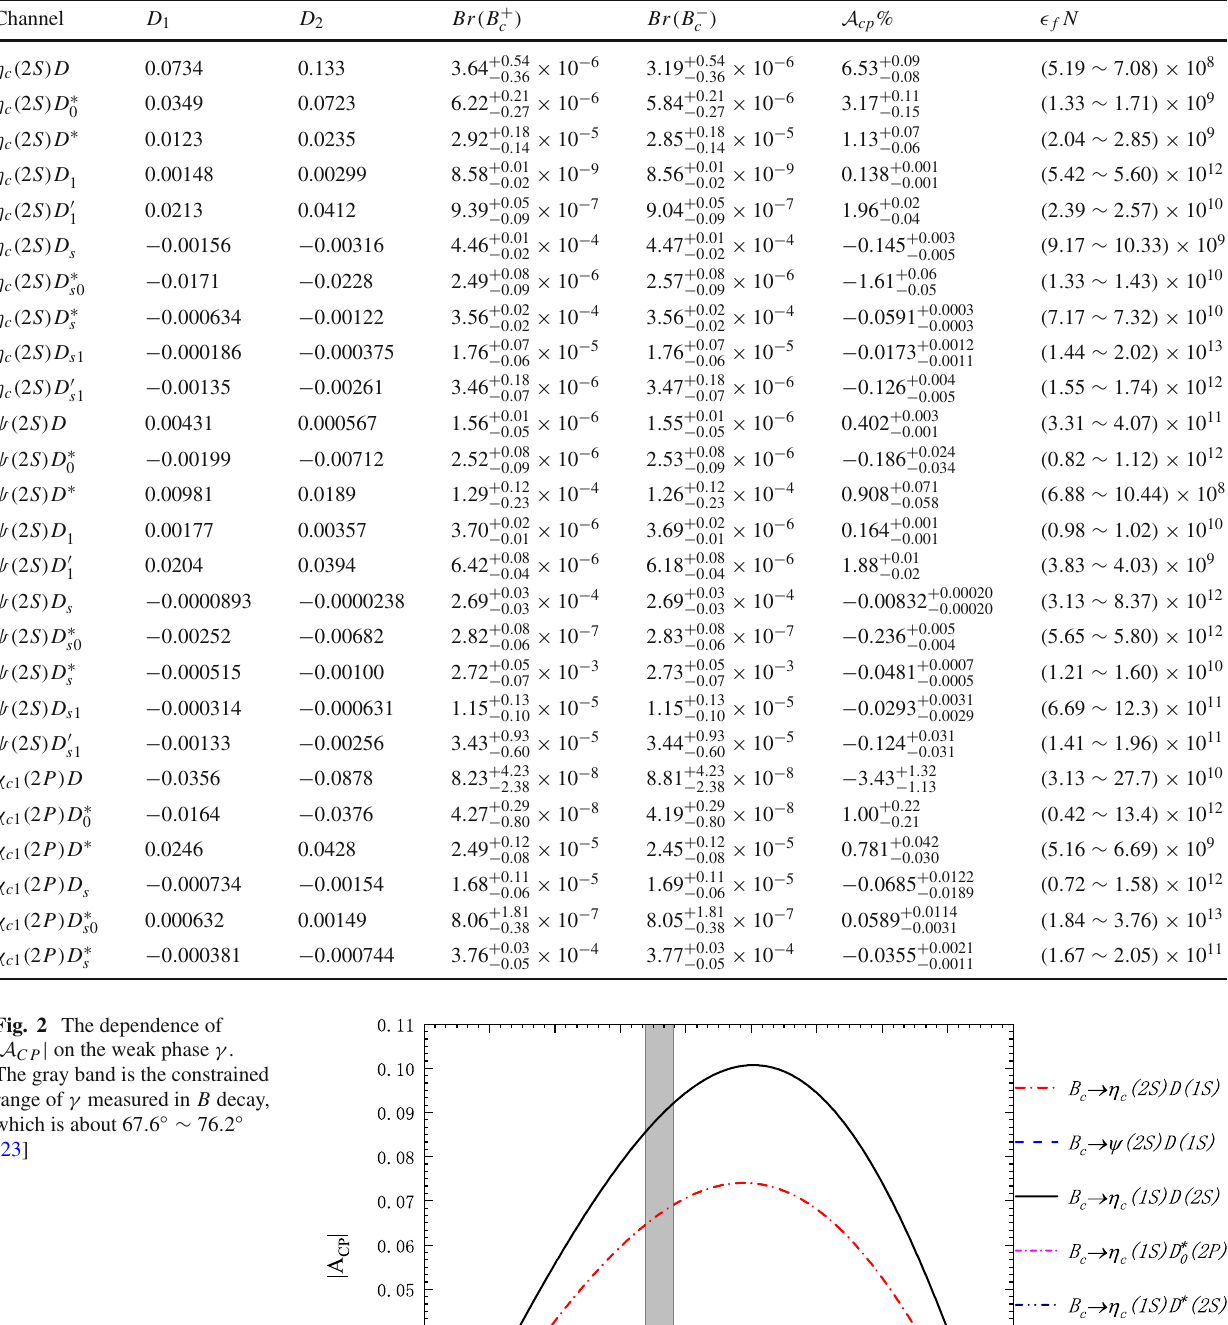
Table 3 The results for B c → c ¯ c ( 2 S , 2 P ) + ¯ cq ( 1 S , 1 P )